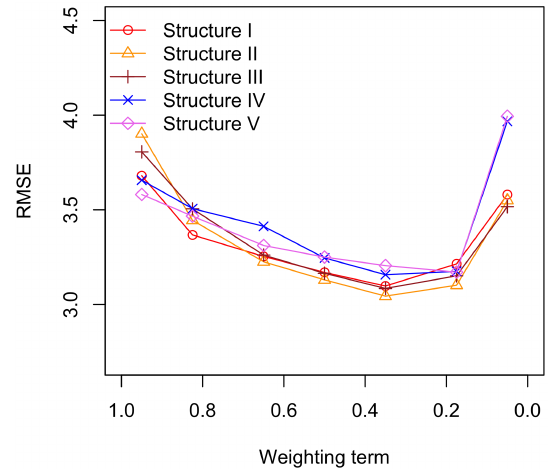
Figure 1. Average of the AIC among all the three treatments for the five model structures with the variation of the relative weight of SO 14 C over total C. In this scale 1 means only total C, 0 means only SO 14 C.